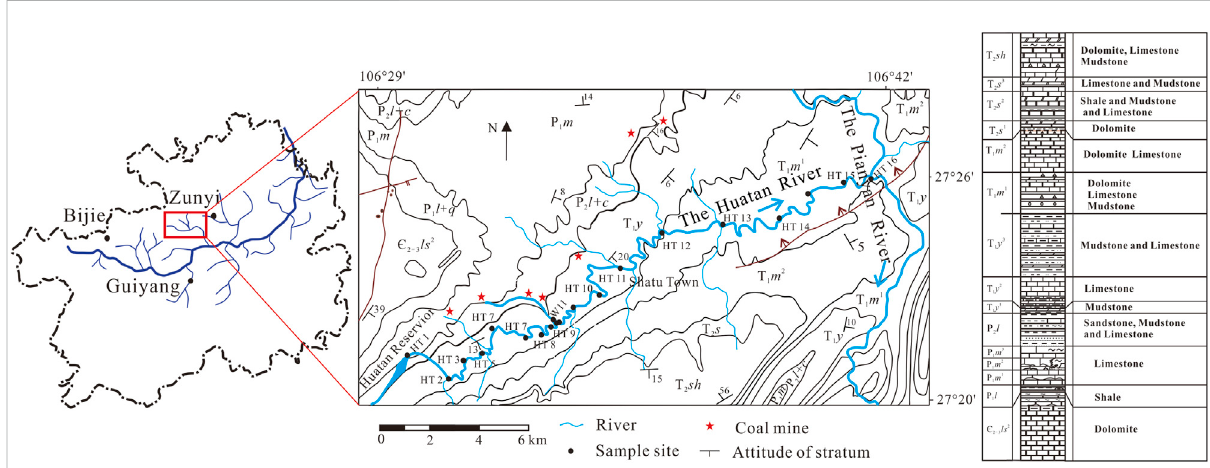
FIGURE 1 The regional geology and sampling point distribution of the Huatan River ( Є 2-3 ls: Cambrian Loushanguan group; P 1 l: Permian Liangshan Formation; P 1 m: Permian Maokou Formation; P 2 l: Permian Longtan Formation; P 2 c: Permian Changxing Formation; T 1 y: Triassic Yelang formation;